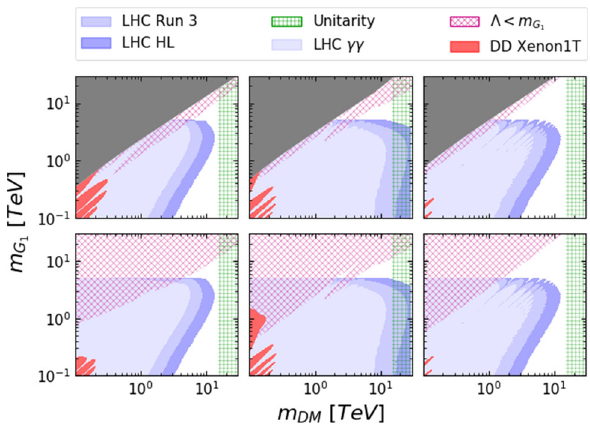
) plane for which (cid:4) σ v (cid:5) = (cid:4) σ v (cid:5) . Fig. 4 Region of the ( m DM , m G th FO 1 Upper panels represent our results in the unstabilized case, i.e. when no radion is considered; lower panels depict the stabilized case, where the sizeoftheextra-dimensionisfixedbytheGoldberger–Wise mechanism anda(light)radionisaddedtothespectrum.Theradionmassinthiscase is m r = 100 GeV. From left to right we present our results for scalar, fermion and vector boson DM particles. In all panels, the white (grey- shaded) area represents the region of the parameter space for which it is possible (impossible) to achieve the correct relic abundance. Over these regions, we have superimposed theoretical and experimental bounds. In particular, the pink-meshed area is the region for which the low-energy < (cid:3) ; the ver- Randall–Sundrum effective theory is untrustable as m G 1 tical green-meshed area on the right of all panels is the region where the √ σ unitarity constraint is not fulfilled, m DM > 1 / FO ; the red-shaded area is the region of the parameter space excluded by Direct Dark Mat- terDetectionsearches; eventually, the three blue-shaded areas represent the region of the parameter space excluded by resonance searches at the LHC Run II with 36 fb − 1 (light blue) and foreseeably excluded by the LHC Run III with 300 fb − 1 (blue) and the HL-LHC with 3000 fb − 1 (dark